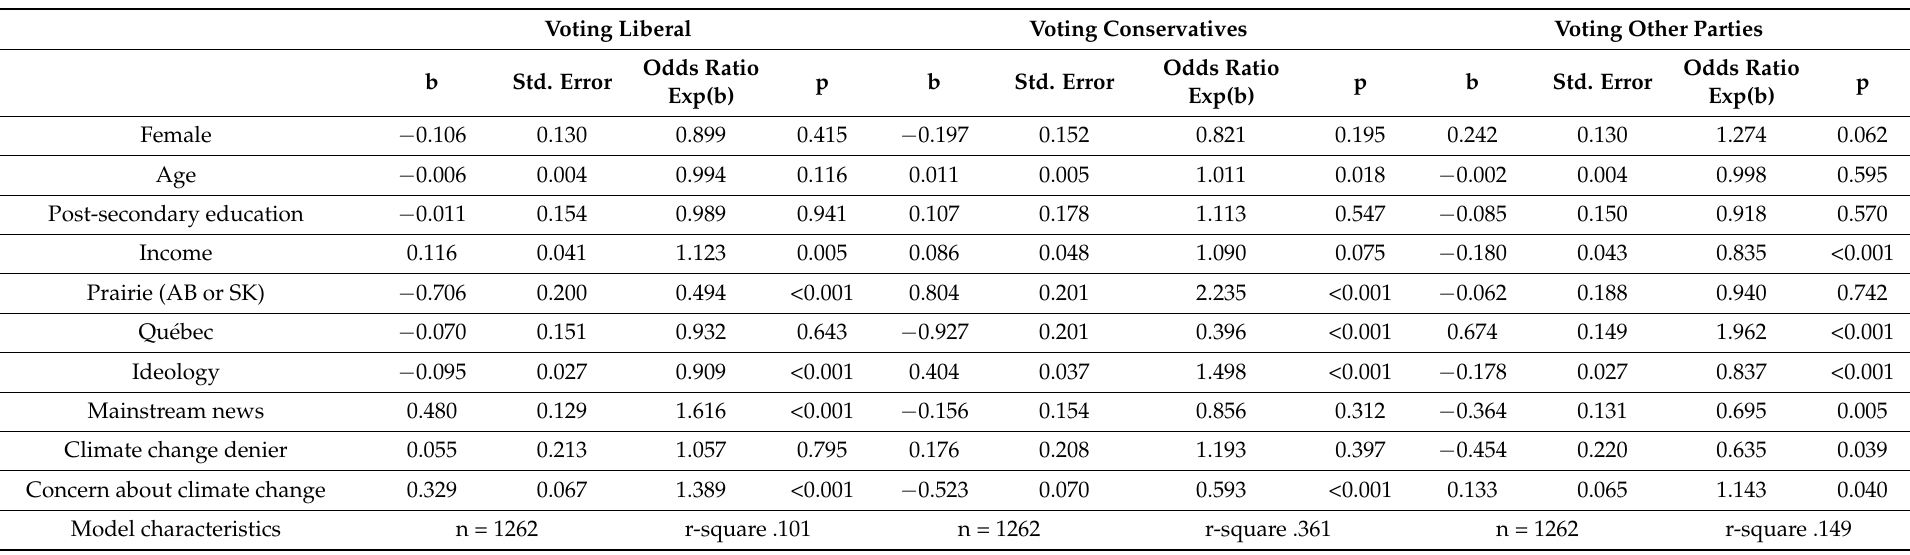
Table 3. Logistic regression on plans to vote for Liberals, Conservatives, and Other